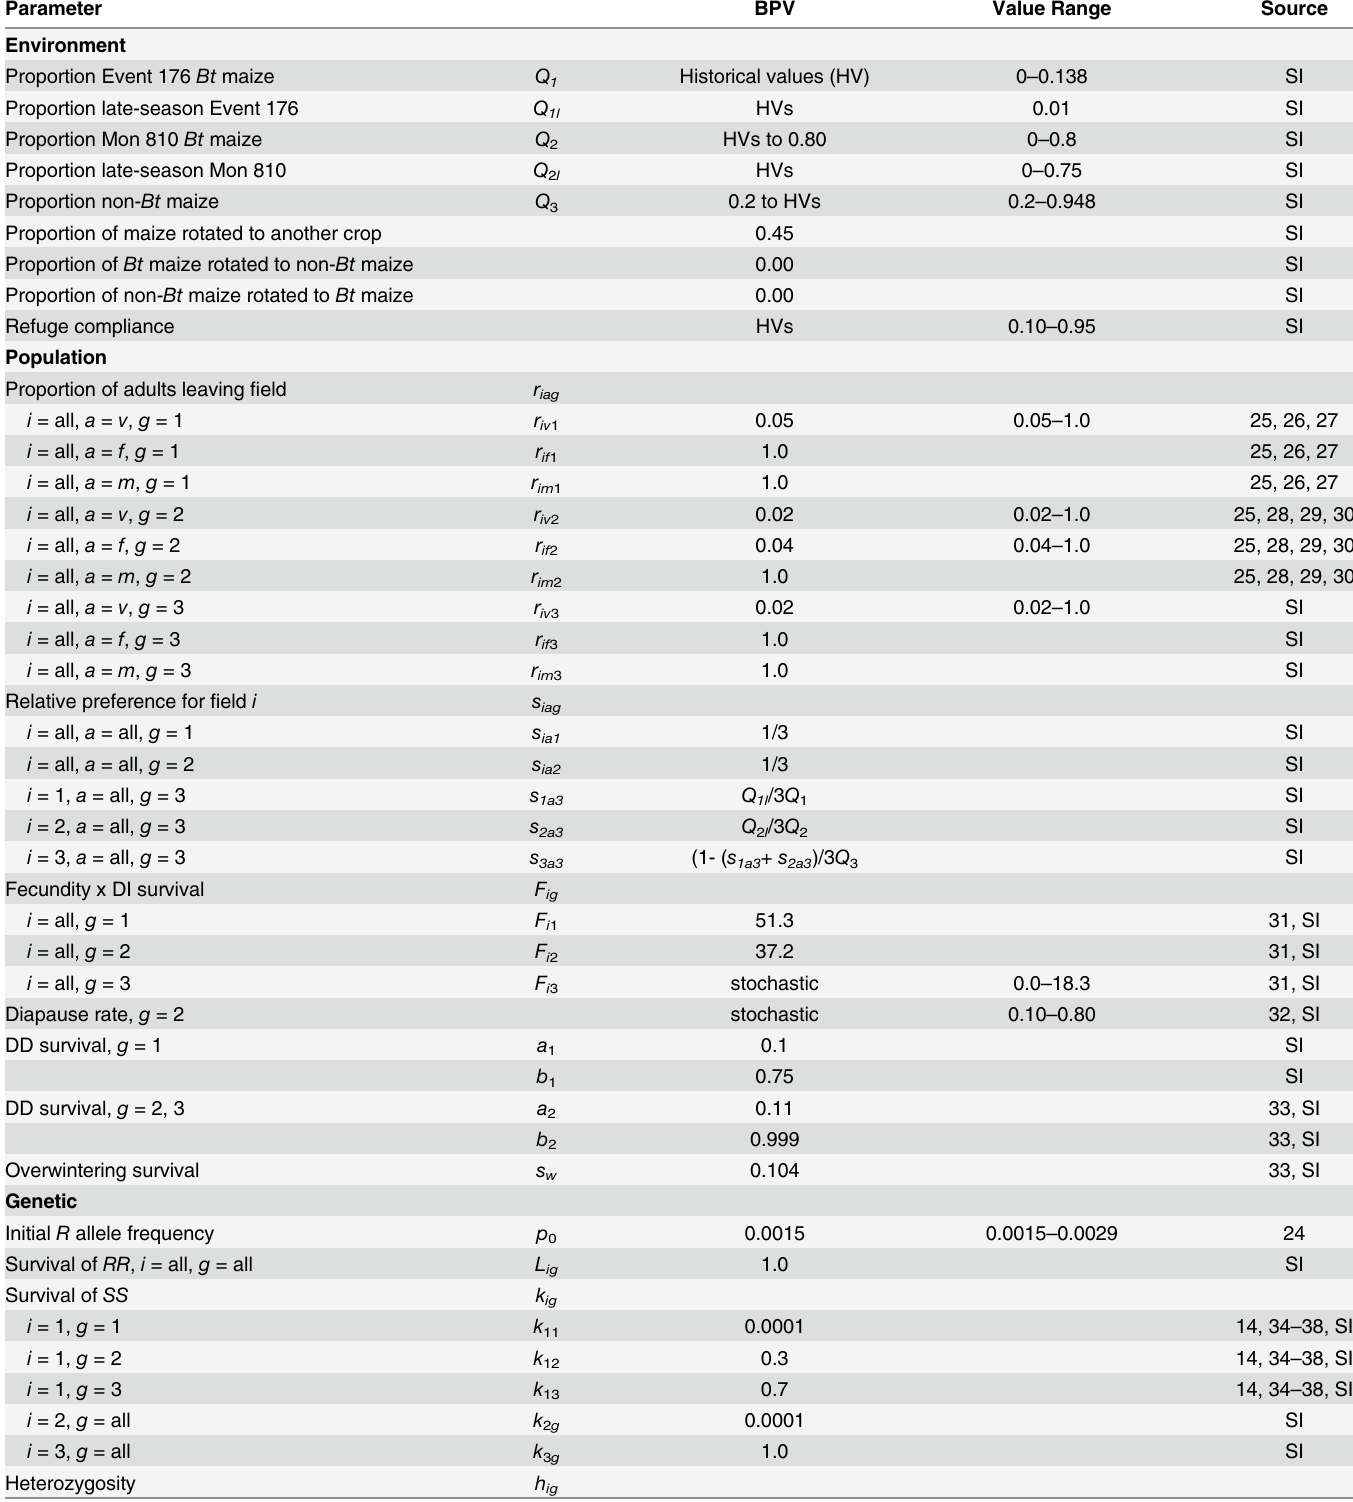
Table 1. Parameter values used in resistance evolution